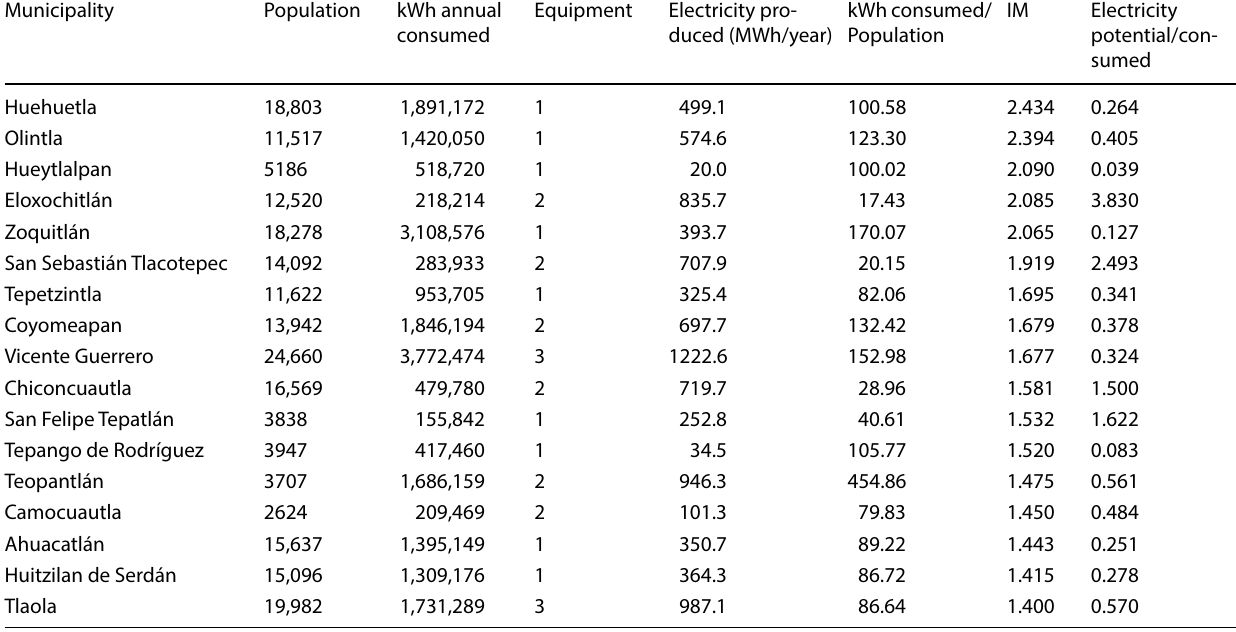
Table 10 Extract for Puebla state, municipalities sample